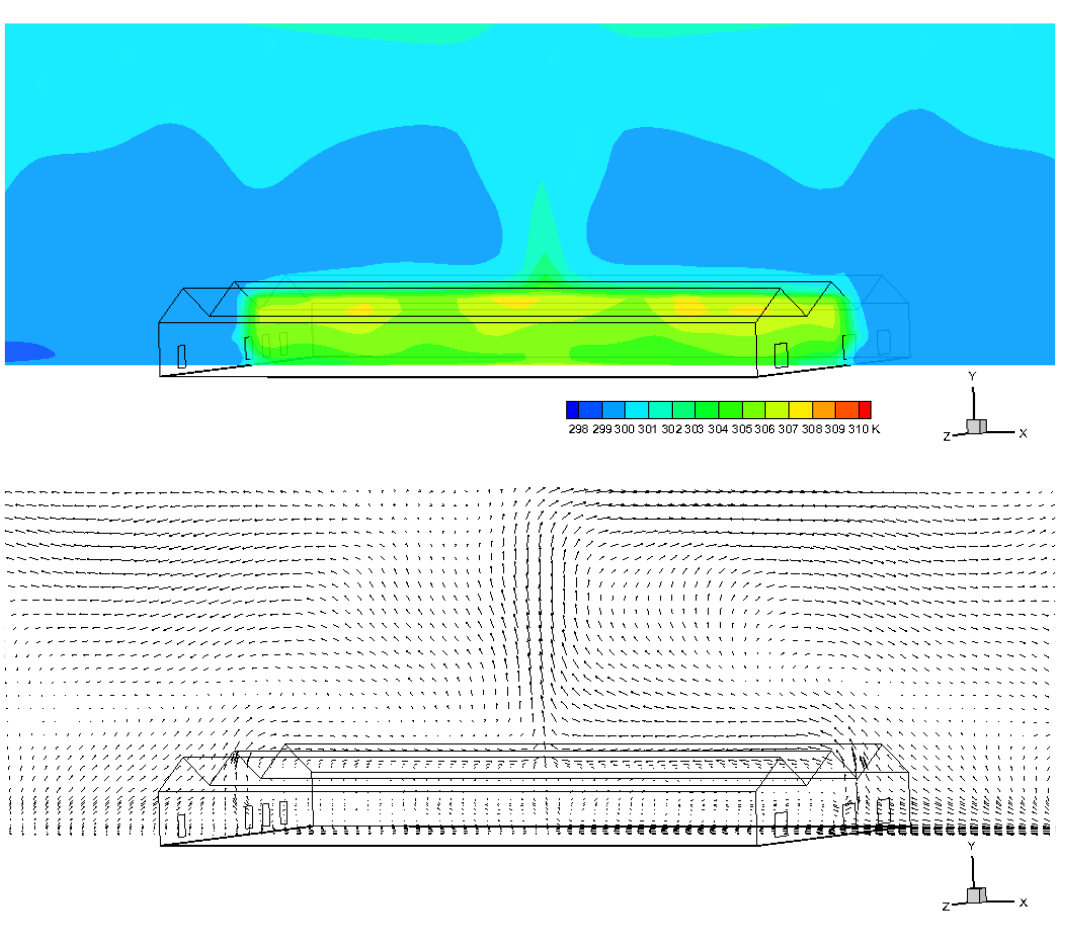
Figure 5. Temperature ( top ) and airflow ( bottom ) fields at the vertical section (Z = 15.5